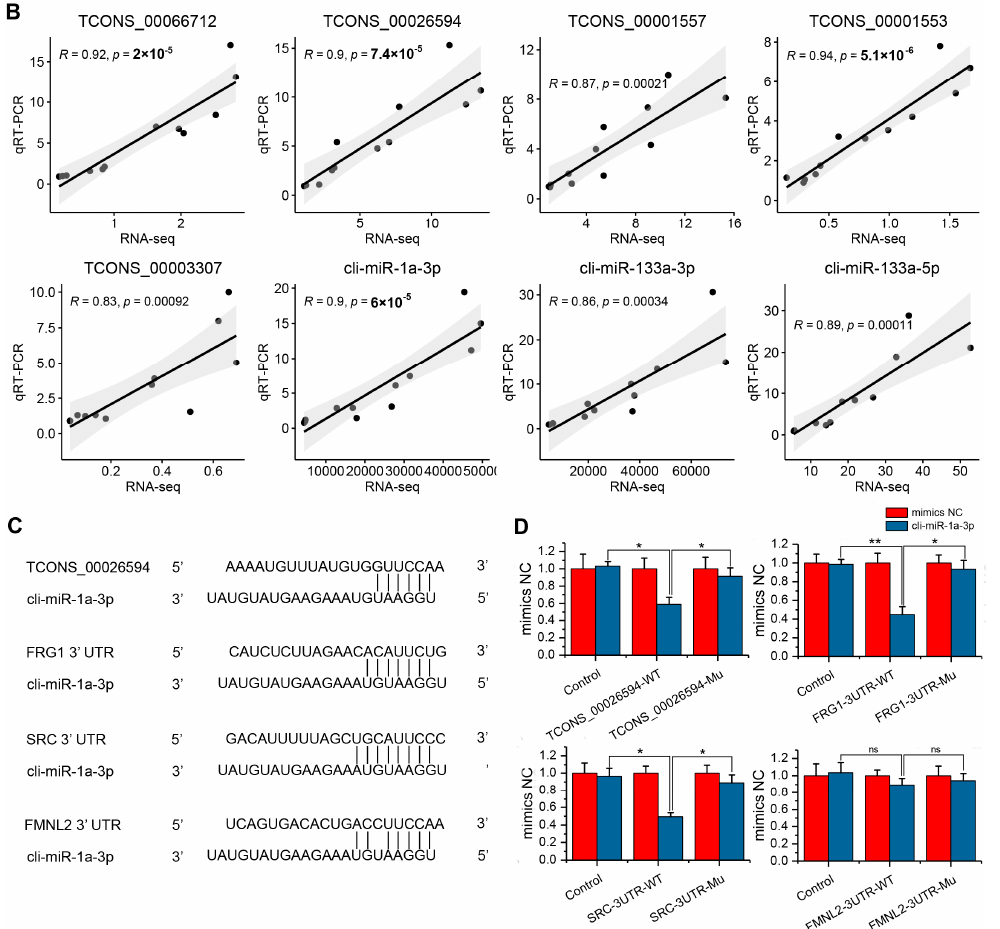
Figure 6. Identification of potential lncRNA–miRNA–mRNA interactions in pigeon skeletal muscle development: ( A ) expression profiles of the five hub lncRNAs during skeletal muscle development; ( B ) correlation analysis of expression profiles of the five hub lncRNAs and three muscle-specific miRNAs detected by RNA-seq and qRT-PCR. p < 0.05 indicates significant difference; ( C ) target relationship prediction between cli-miR-1a-3p and TCONS_00026594 as well as FRG1 , SRC , and FMNL2 ; (D) validation of the target relationships between cli-miR-1a-3p and TCONS_00026594 / FRG1 / SRC using dual-luciferase assay. * p < 0.05, ** p < 0.01, ns p > 0.05.